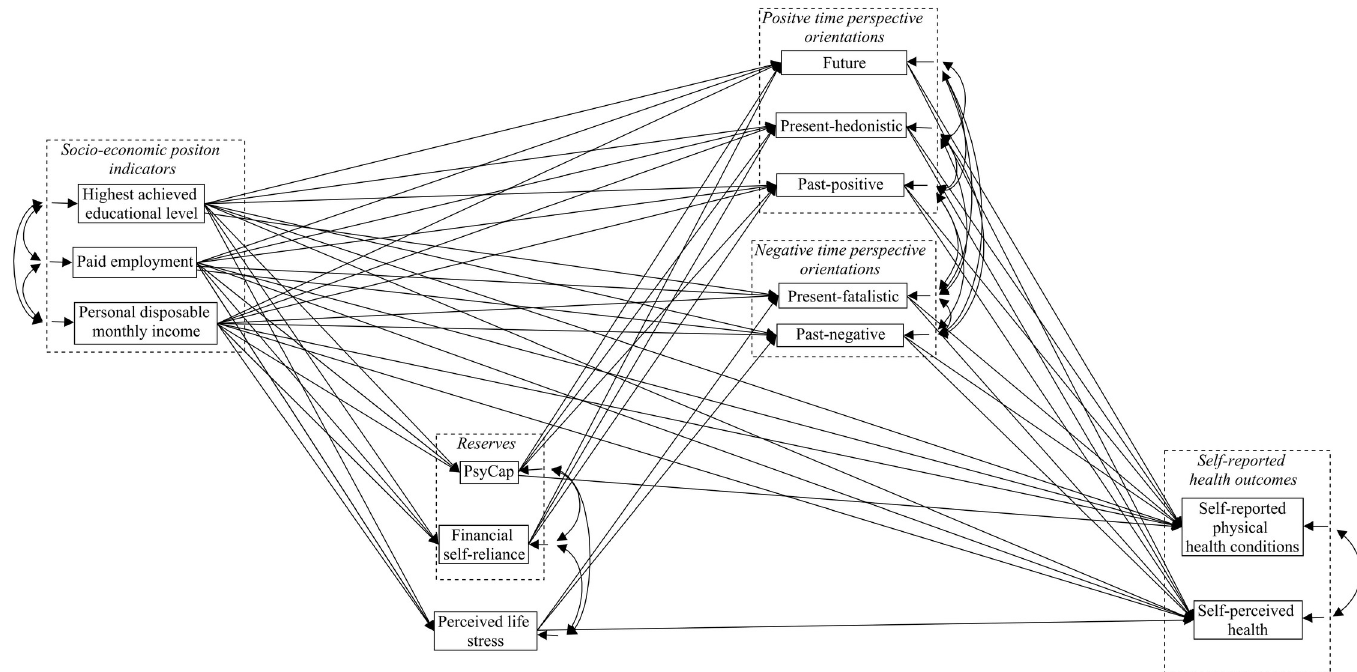
Fig 2. Conceptual model tested in the current study. PsyCap = Psychological capital; Although sex, age and background were included as covariates in the analysis at all model levels, estimated paths regarding age, sex and background are not depicted in the Figure.